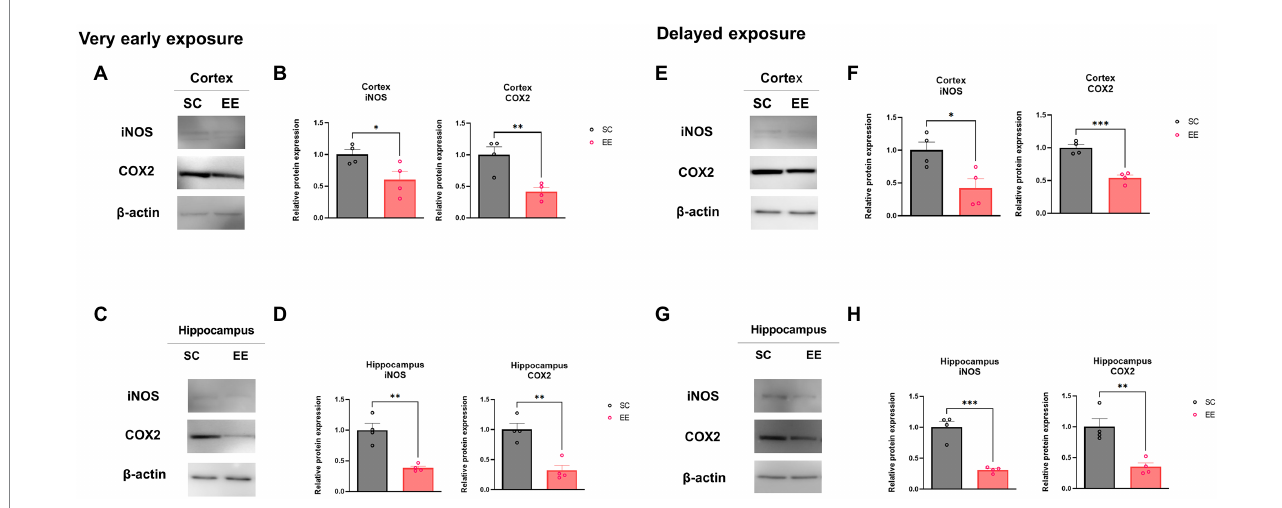
FIGURE 5 Effect of very early and delayed exposure to EE on iNOS and COX2 expression in the cerebral cortex and the hippocampus. Representative WB images from cerebral cortex and hippocampus obtained after very early EE exposure are shown in (A,C) , respectively. The quantification of the WB results is shown in (B,D) , respectively ( n = 4 per group). Representative WB images from cerebral cortex and hippocampus obtained after delayed EE exposure are shown in (E,G) , respectively. The quantification of the WB results is shown in (F,H) , respectively ( n = 4 per group). All